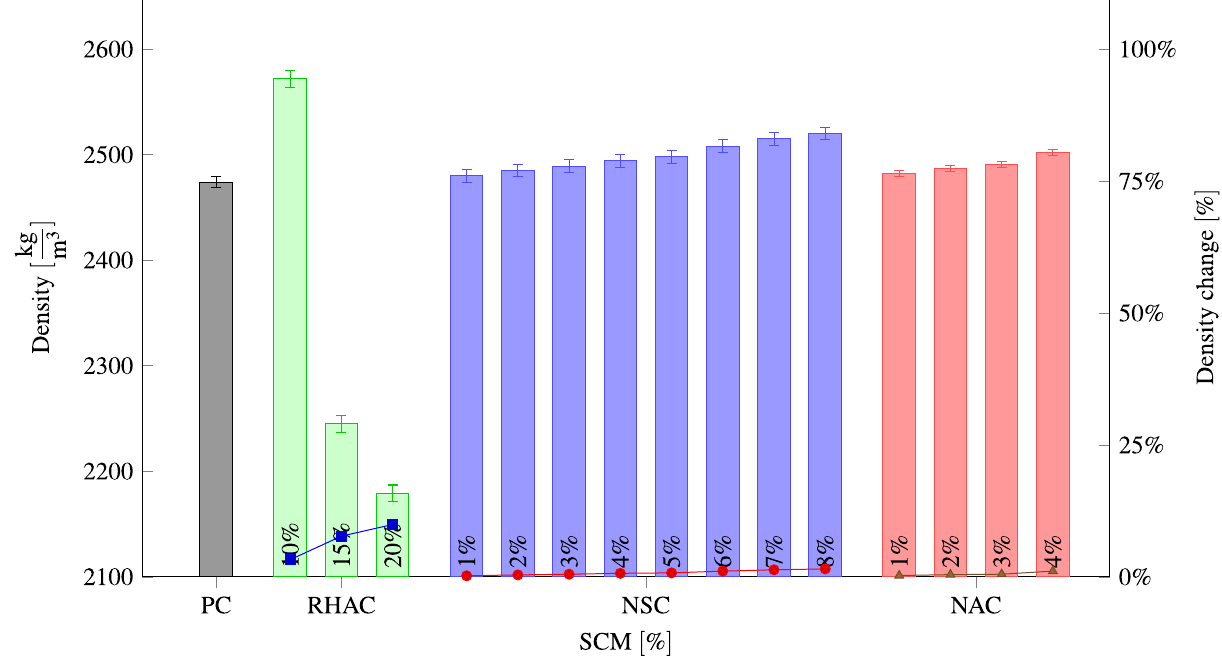
Figure 8. Density for different percentages of RHA, NS, and NA replacement.